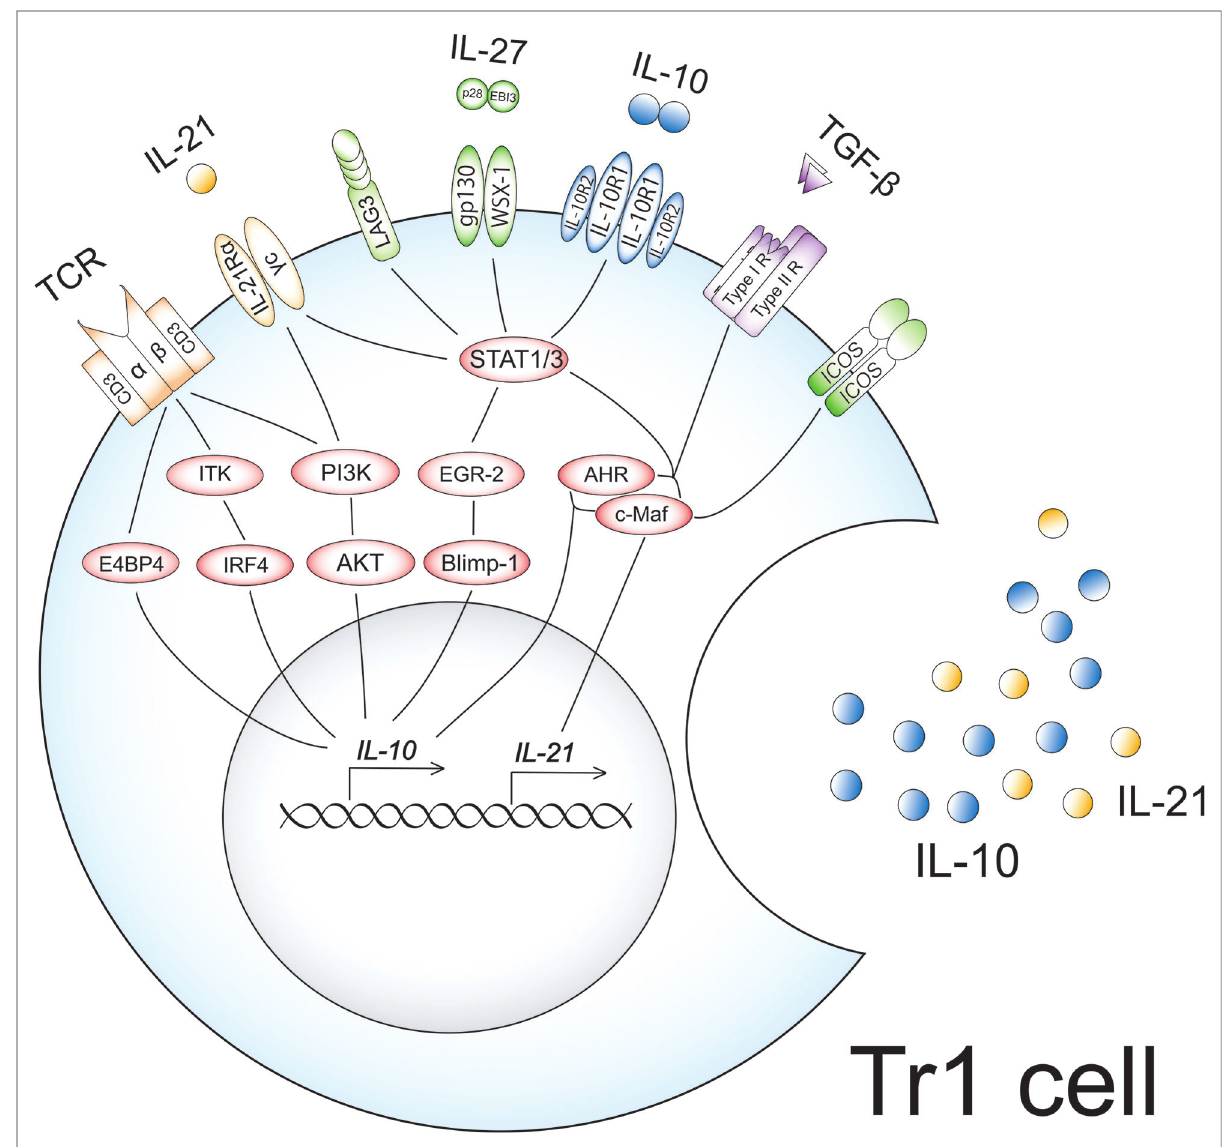
FIGURE 1 Induction mechanisms of Tr1 cells in AIT. High-dose allergen exposure in AIT promotes dendritic cells to produce IL-27, IL-10, and TGF- β . Naïve CD4 + T cells can differentiate into Tr1 cells upon TCR engagement in the presence of these cytokines. High-dose antigen exposure leads to the upregulation and activation of IL-10-associated molecules such as ITK, E4BP4, IRF4, PI3K, and AKT, followed by the production of IL-10. PI3K also enforces IL-21 receptor expression. IL-27 upregulates and activates IL-10-associated molecules, EGR-2, Blimp-1, AHR, and c-Maf, followed by the production of IL-10 and IL-21 in cooperation with TGF- β via activation of STAT1 and STAT3. IL-27 also upregulates the expression of ICOS and LAG3. The upregulated IL-10, IL-21, and ICOS by IL-27 amplify the productions of IL-10 and IL-21 in an autocrine manner, leading to the acquisition of a Tr1